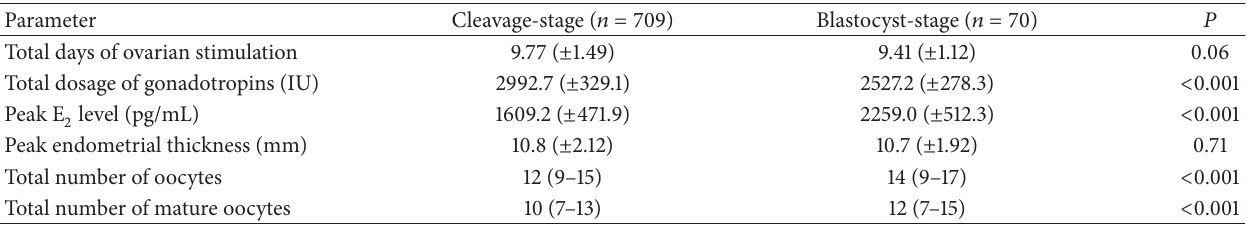
Table 2: Comparison of ovarian stimulation parameters of patients undergoing cleavage-stage ETs ( 𝑛 = 709 ) or blastocyst-stage ETs ( 𝑛 = 70 ) with early